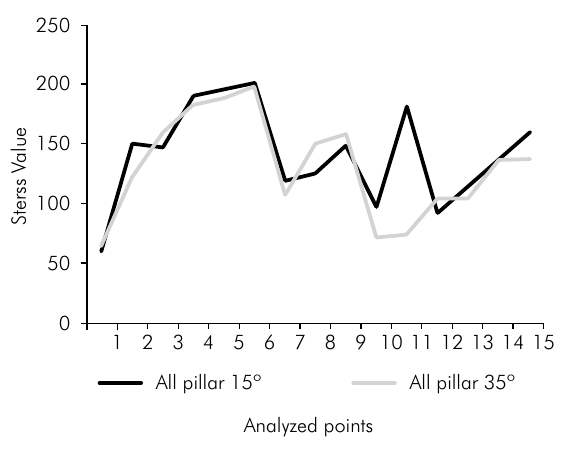
Graph 3. Stress behavior for points analyzed per group for load in all pillars